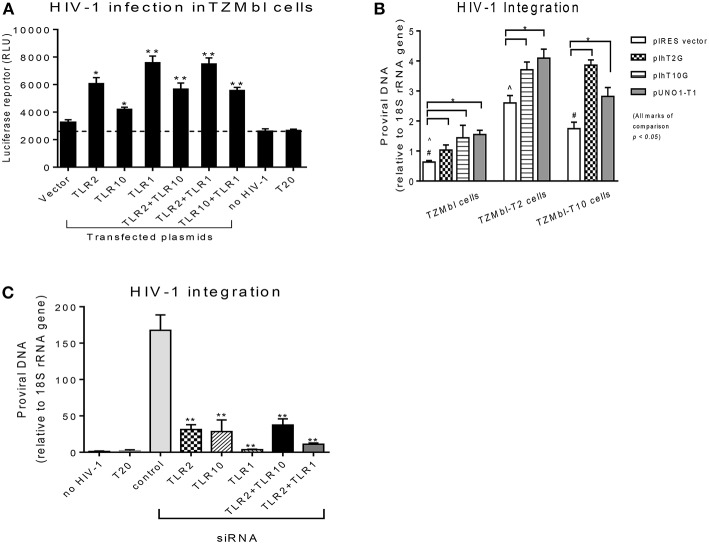
Overexpression or siRNA mediated knockdown of TLR10 significantly alters HIV-1 infection and integration (A) HIV-1 infection was significantly enhanced in HIV-1 reporter TZMbl cells transiently overexpressing TLR10 alone and co-transfected with TLR2 or TLR1 expression plasmids by measuring luciferase activity in relative light units (RLU). (B) HIV-1 integration was significantly increased in stable TZMbl reporter cells overexpressing TLR10, TLR2, and TLR1. TZMbl, TLR2- stable, and TLR10-stable cells were used for co-transfection with plasmids: empty vector, TLR2, TLR10, and TLR1 vector, TLR10 and TLR1 vector, and TLR2 and TLR1 vector. Proviral DNA (DNA pol) was detected by PCR and normalized to the 18S rRNA gene. (C) Proviral DNA was obviously decreased in macrophages with TLR10 knocked down prior to HIV-1 infection. T20: Enfuvirtide, an HIV-1 fusion inhibitor used as a negative control. Data set is representative of three different experiments completed in triplicate (Statistic marks in the plots: *p < 0.05, **p < 0.01 for Mann Whitney t-tests, each group compared to the vector group in A and B, or to the control group in C; pair comparison ∧, # in B, respectively).